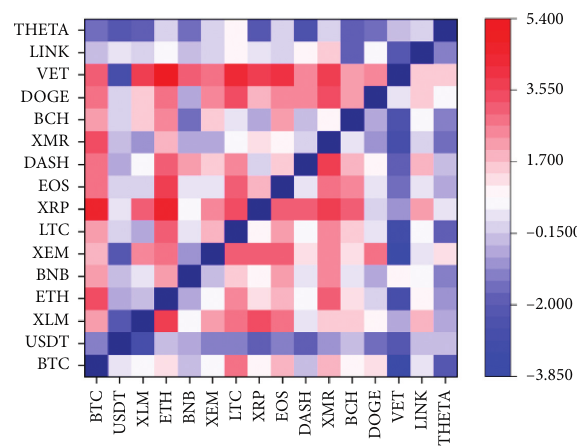
Figure 2: Causality test under D1.